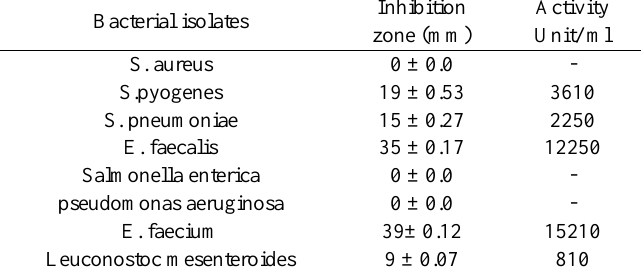
Table 1: Spectrum activity of streptocin SH3 against some pathogenic bacteria.